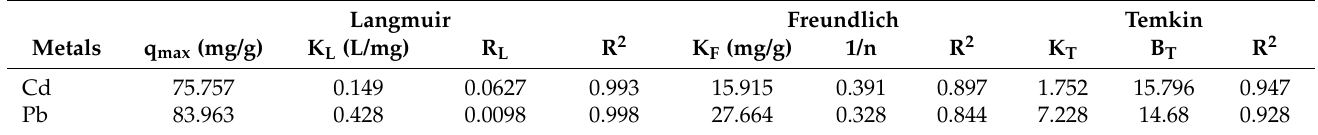
Table 2. Langmuir isotherm Freundlich isotherm and Temkin parameters MK11.